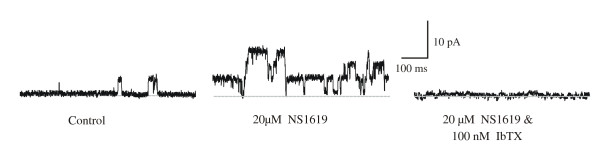
NS1619, a putative activator of BKCa channels, and IbTX, a specific BKCa channel blocker, serve to identify the BKCa channel in human uterine smooth muscle myocytes. Representative recordings from the same membrane patch (+40 mV) in the cell-attached configuration before and after addition of 20 μM NS1619 and subsequent addition of 100 nM IbTX. IbTX reversed NS1619-stimulated channel activity.